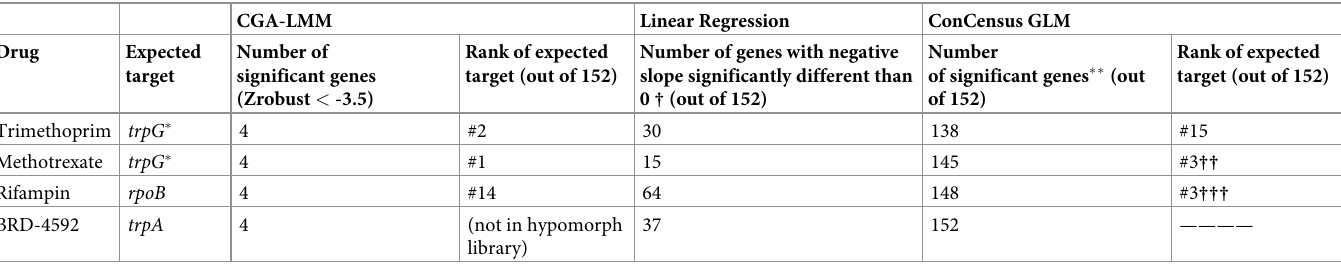
Table 1. Summary of significantly interacting genes from the CGA-LMM model, simple linear regression, and the ConCensusGLM model (Johnson et al, 2019).